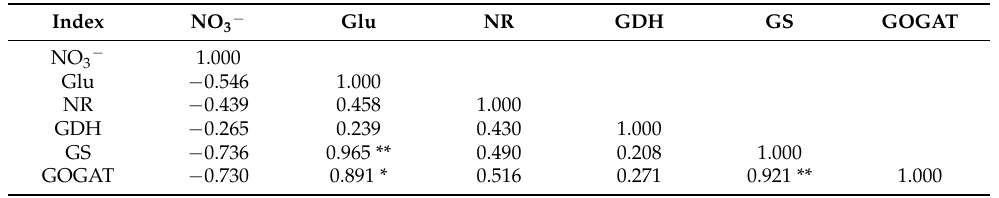
Table 3. Correlation analysis of nitrogen metabolism-related enzymes and nitrogen forms after 10 d of